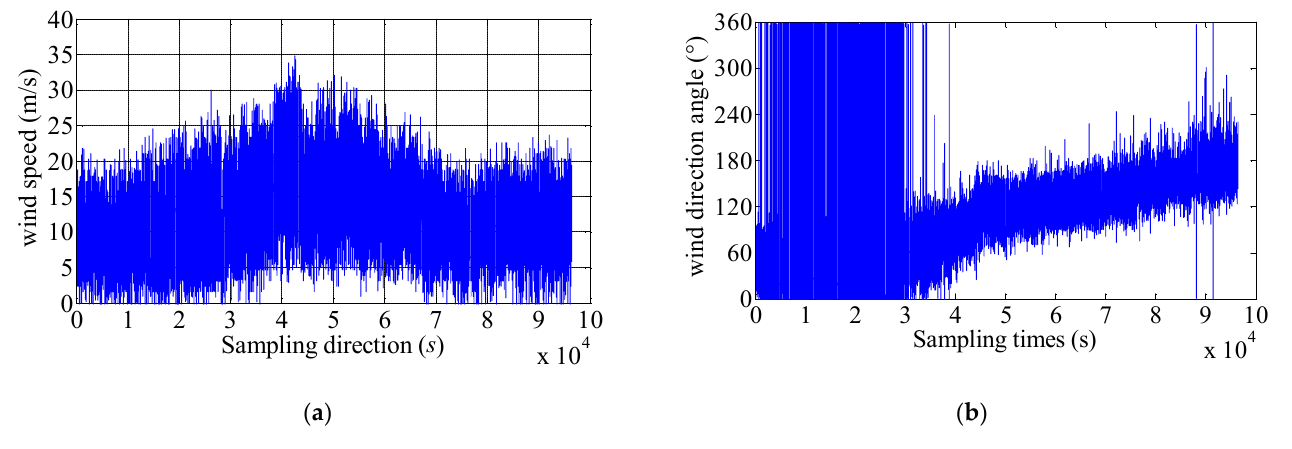
Figure 2. The measured instantaneous wind speed and direction during Typhoon Sarika. ( a ) Wind speed; ( b ) Wind direction.